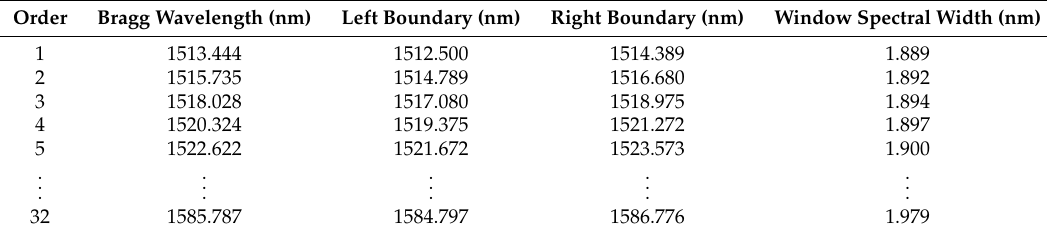
Table 1. Parameters of the fiber Bragg gratings (FBGs) of individual sensors.